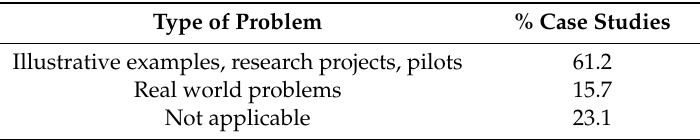
Table 8. Nature of case studies (%).